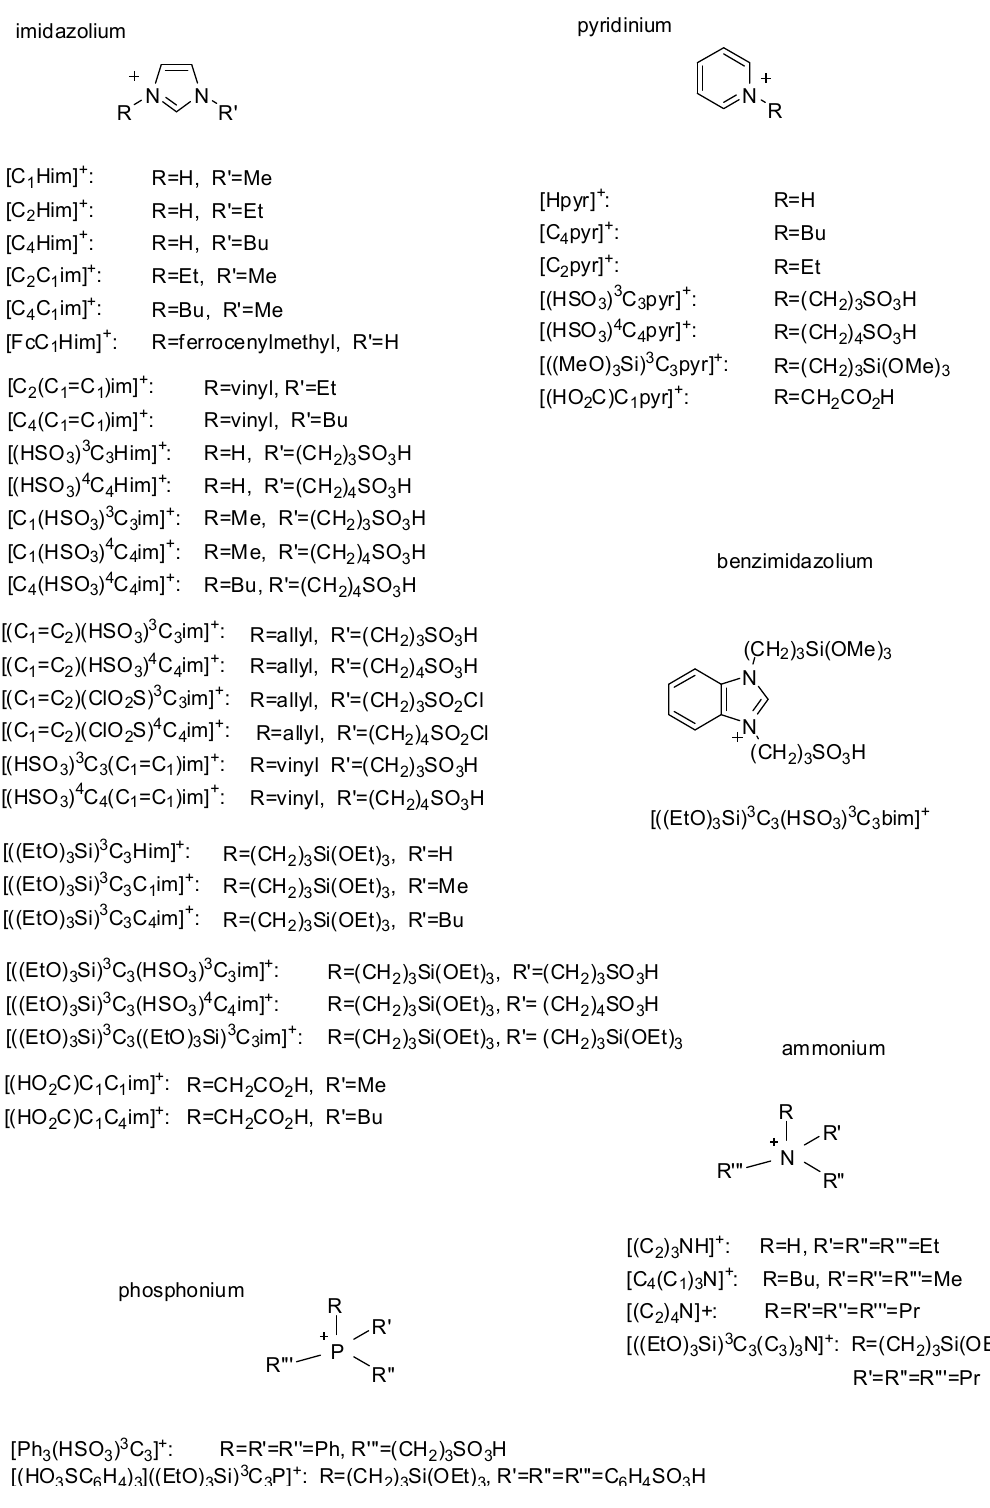
Figure 1. Cations of ionic liquids used during the synthesis of acidic